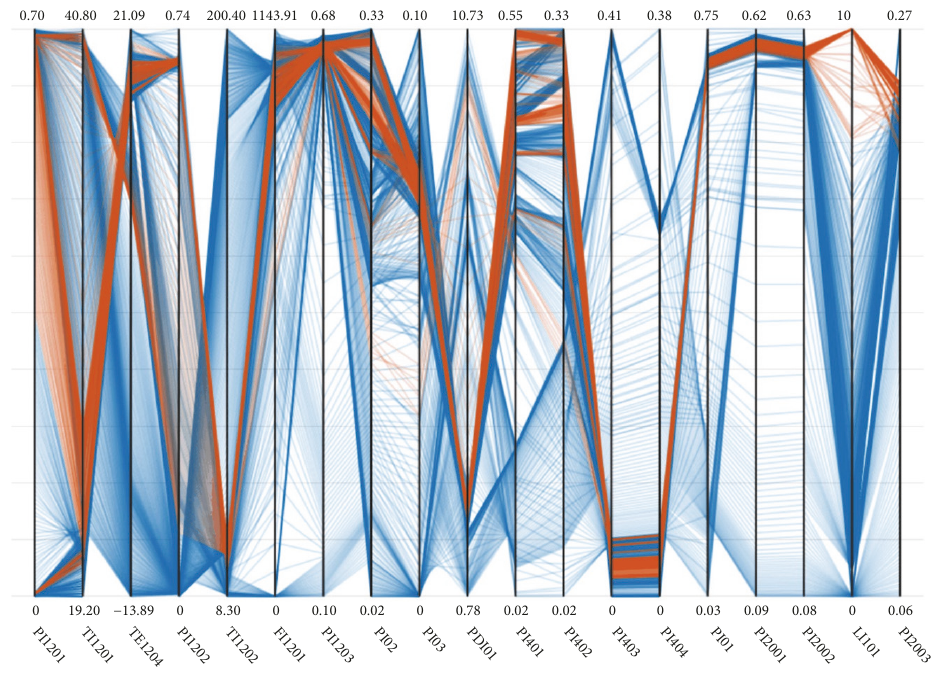
Figure 7: Visual correlation analysis local graph B. Table 3: Strong correlation variable